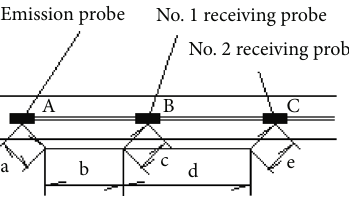
Figure 1: One transmitting double receiving refraction path diagram.